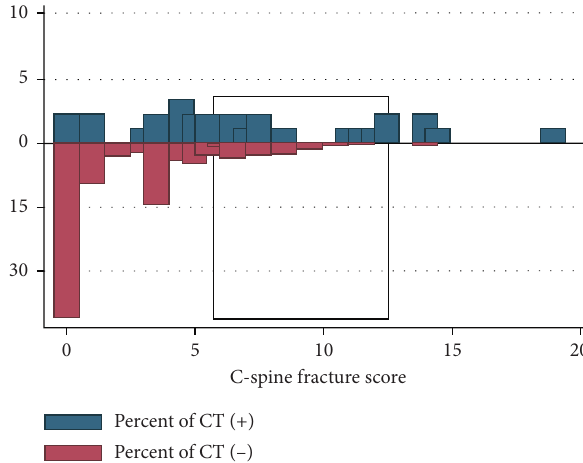
Figure 1: Two-way bar graph of the C-spine fracture score: CT (+) ( n � 29) versus CT ( − ) ( n � 346).